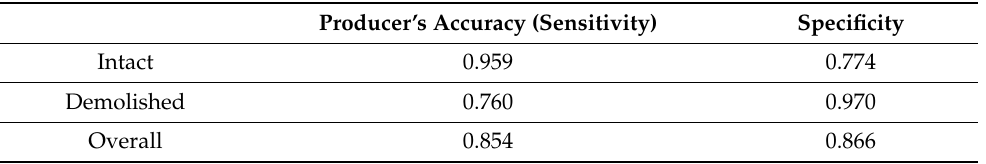
Table 2. Network’s producer’s accuracy (sensitivity) and specificity to input classes using the 30% areal percentage